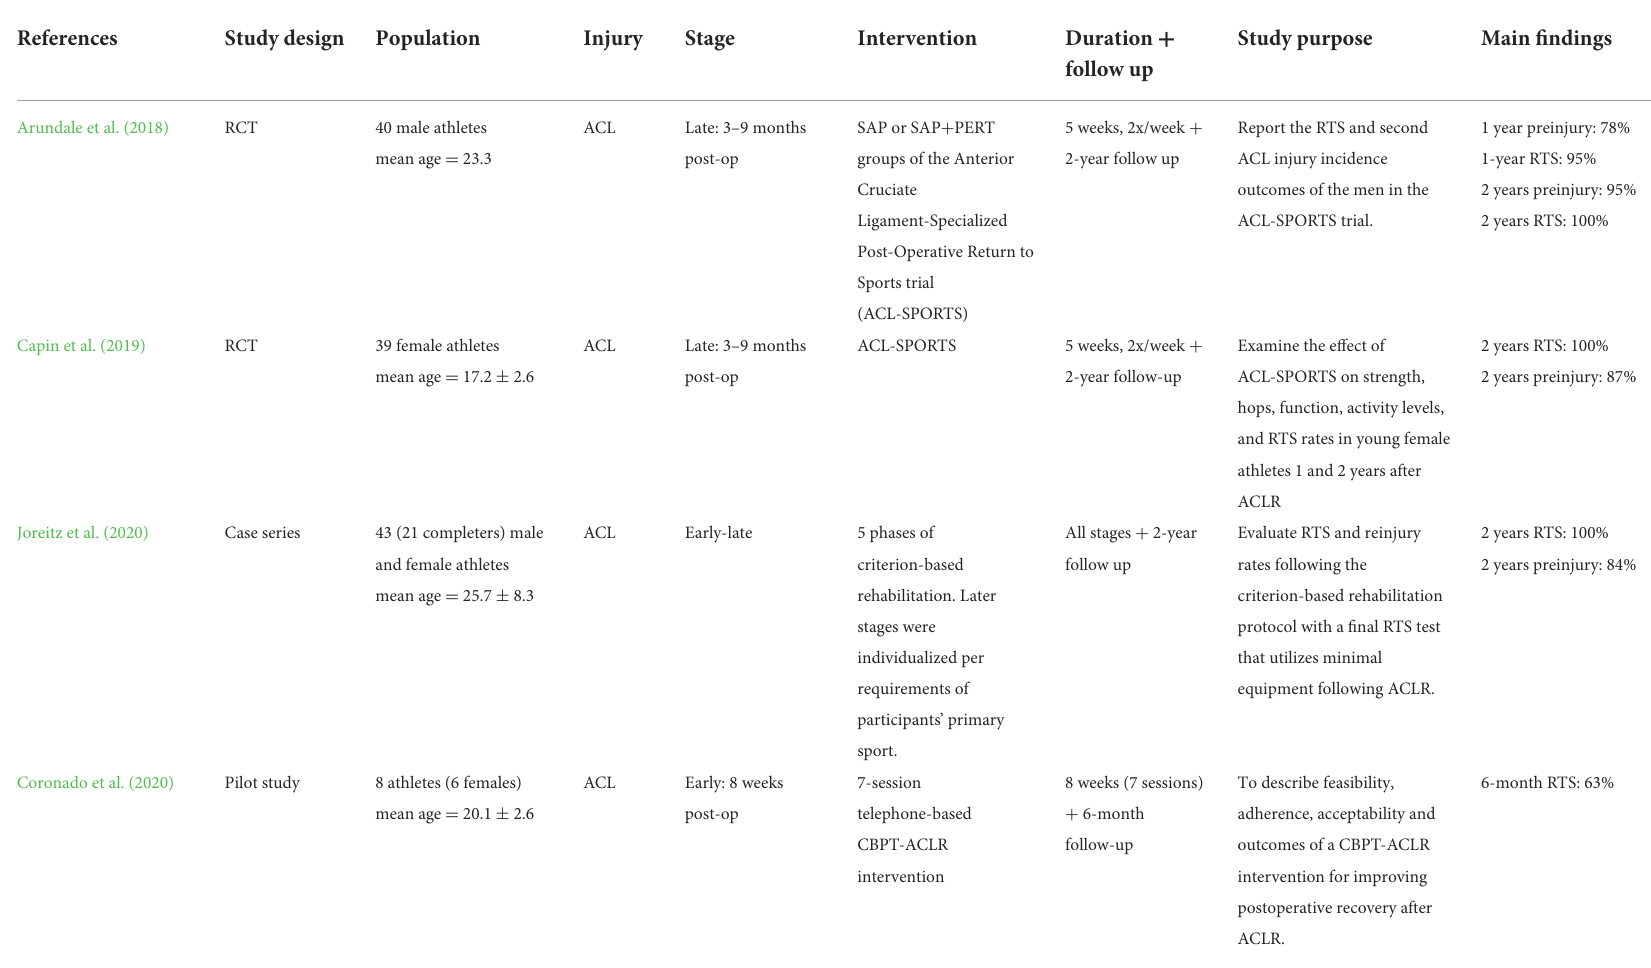
TABLE 1 Characteristics of included